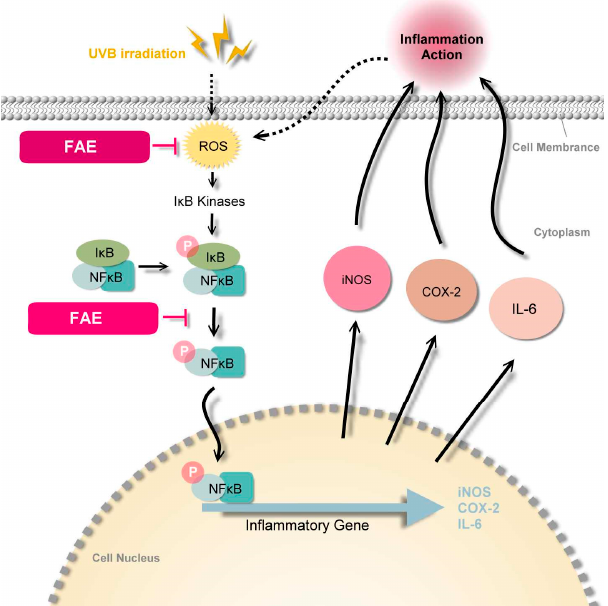
Figure 11. Schematic representation of inhibition of the inflammation-related signal transduction pathway by Ficus awkeotsang Makino extract (FAE). ROS, reactive oxygen species; I κ B, inhibitor of κ B; and NF κ B, nuclear factor kappa B. The ROS are produced after UVB irradiation, while the I κ B kinase activates the NF κ B pathway. Activation of the NF κ B triggers expression of several inflammatory genes, including members of the iNOS (inducible nitric oxide synthase), COX-2 (cyclooxygenase-2), and IL-6 (interleukin-6). iNOS and COX-2 regulate the inflammatory response. IL-6 is a multifunctional cytokine that regulates the immune response.